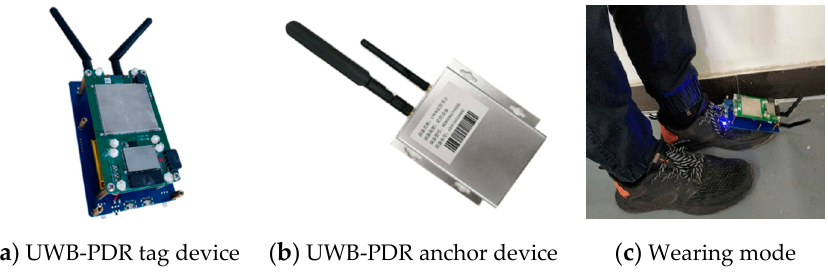
Figure 7. UWB/PDR Positioning equipment and wearing mode.